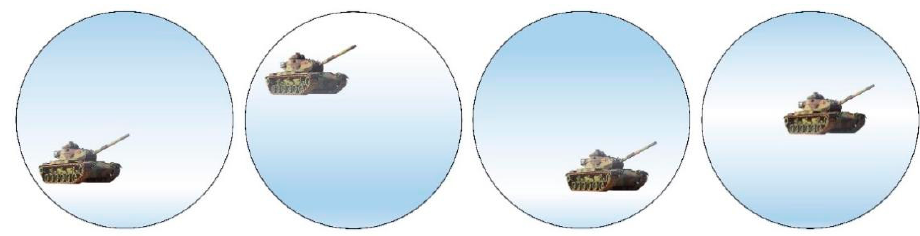
Figure 3. Possible target positions within the field of view.